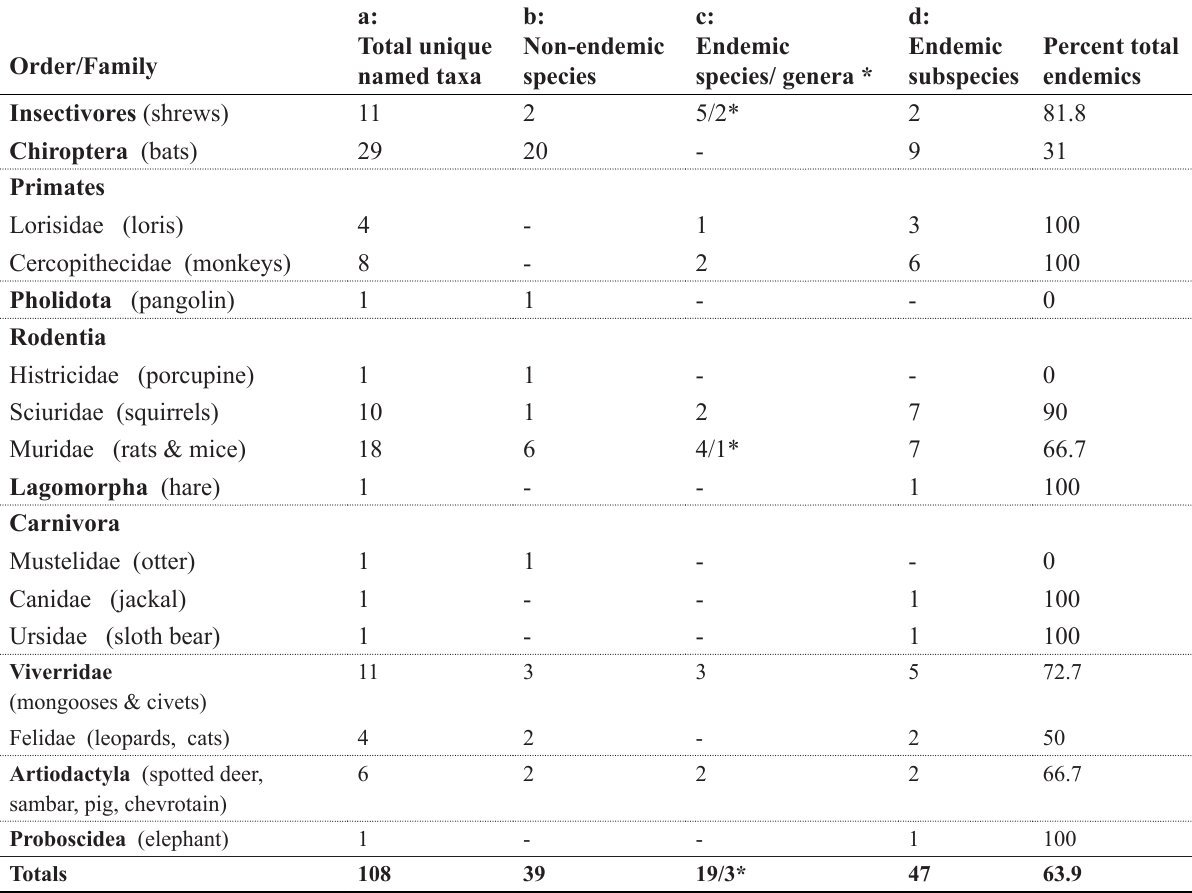
Table 2: The numbers of (a) native uniquely named terrestrial mammal taxa, separated according to the numbers of (b) non-endemic species, (c) endemic species and genera, and (d) endemic subspecies that occur in all forest types in Sri Lanka (Summary of Appendix 1).